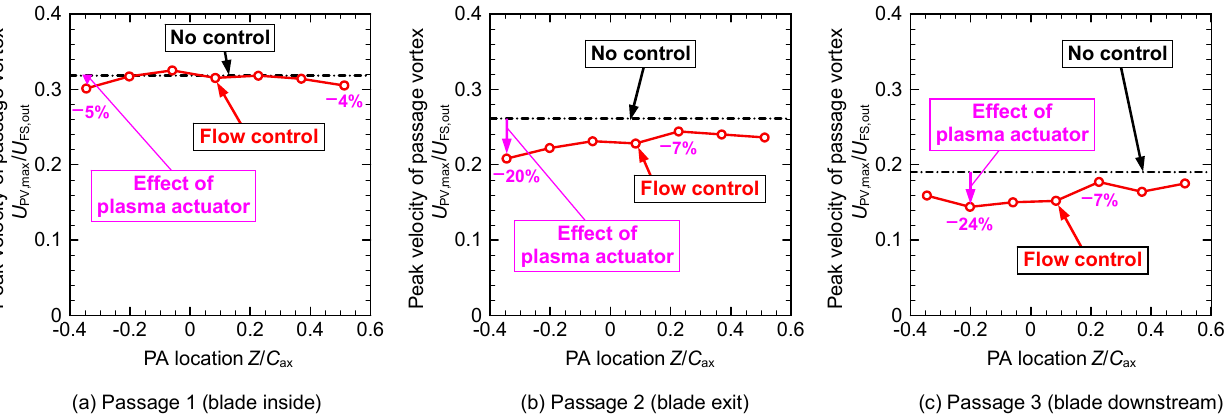
Figure 18. Effect of the plasma actuator location on peak secondary velocity of passage vortex (Re out = 3.7 × 10 4 ).